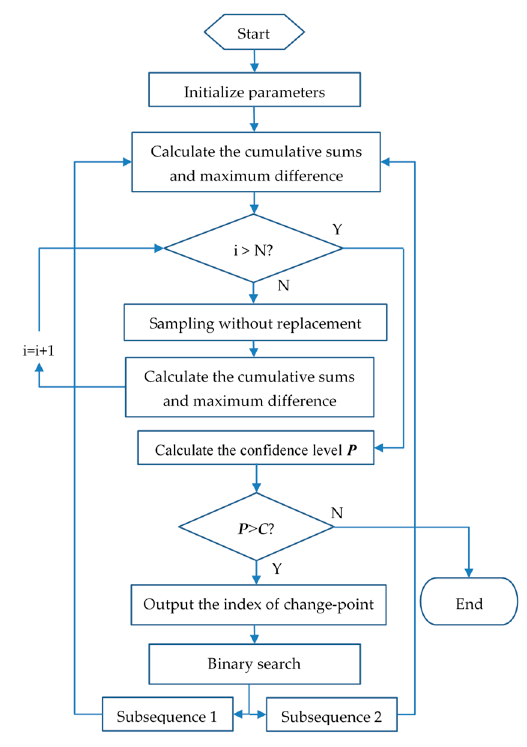
Figure 5. The flowchart of the change-point detection process.